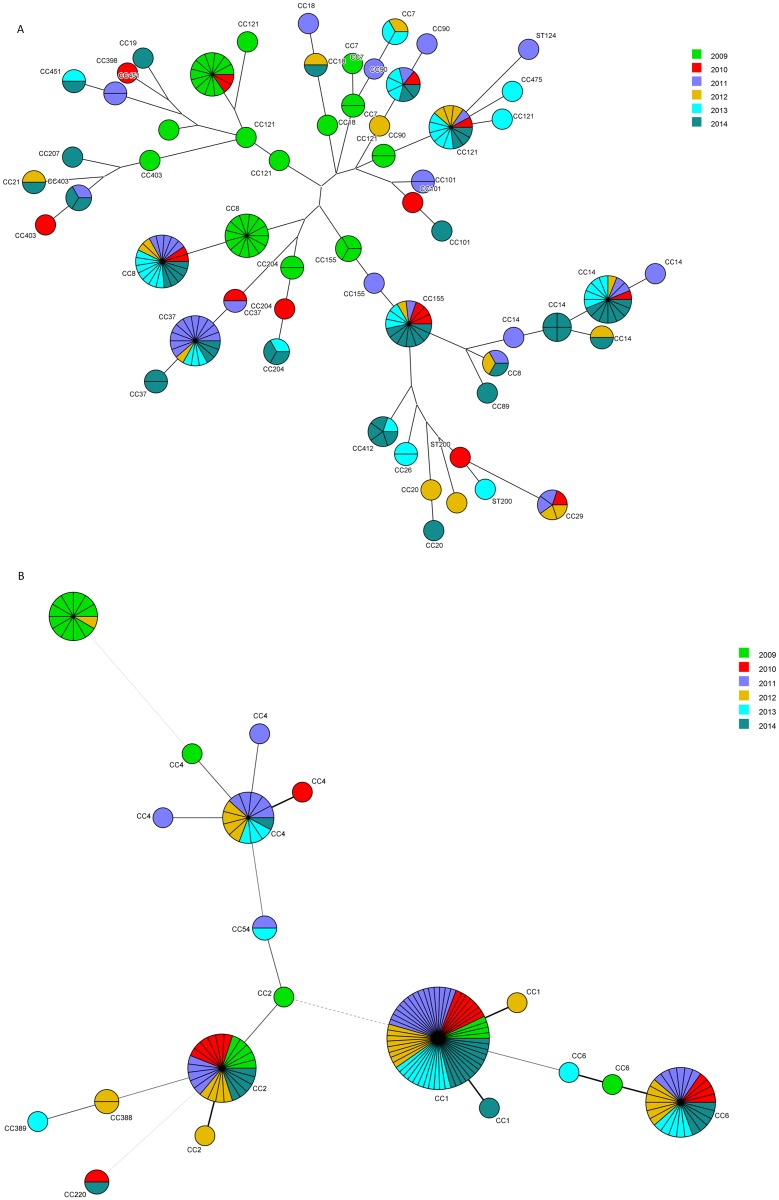
Minimal spanning tree of 7-gene MLST of L. monocytogenes isolates of serovar 1/2a (a) and 4b (b) isolated in 2009–2014.Each node represents a different 7-gene MLST profile with frequency-dependent size. Node colour represents isolation year. Branch thickness indicates number of different loci in the 7-gene MLST profile of the connected nodes.